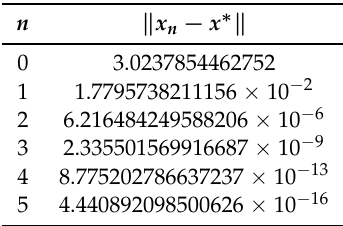
Table 1. A priori error